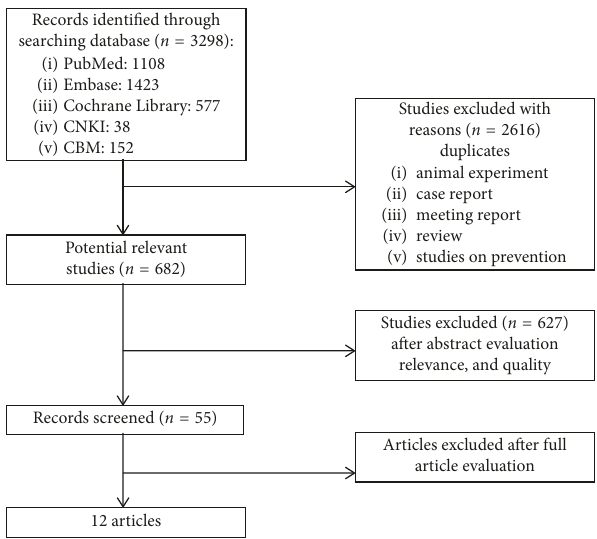
Figure 1: The results of the search strategy, study selection, and